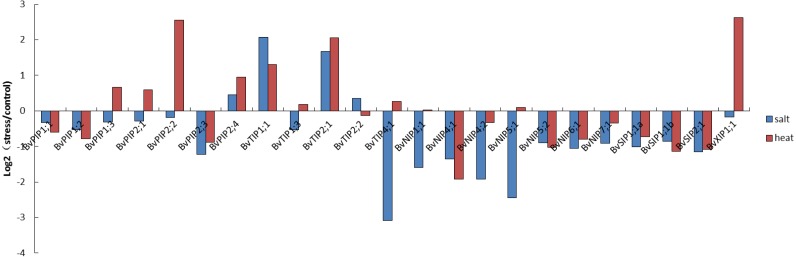
Expression pattern of the 23 BvAQP genes in young leaf under abiotic stress.